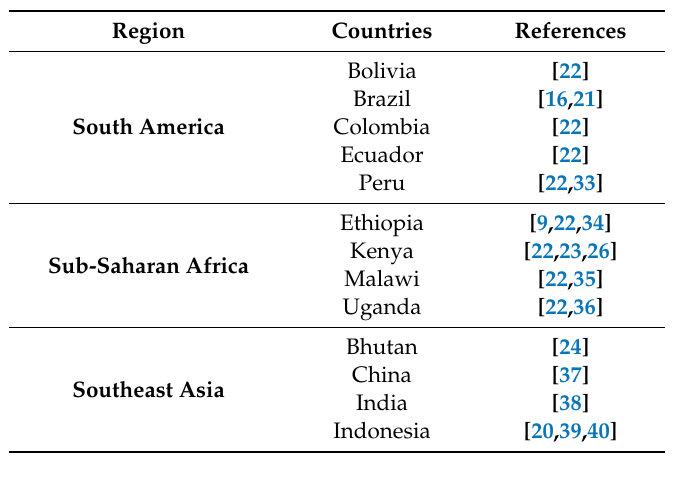
Table 3. Some tropic and subtropic countries with aeroponic installations used in the pre-basic seed potato